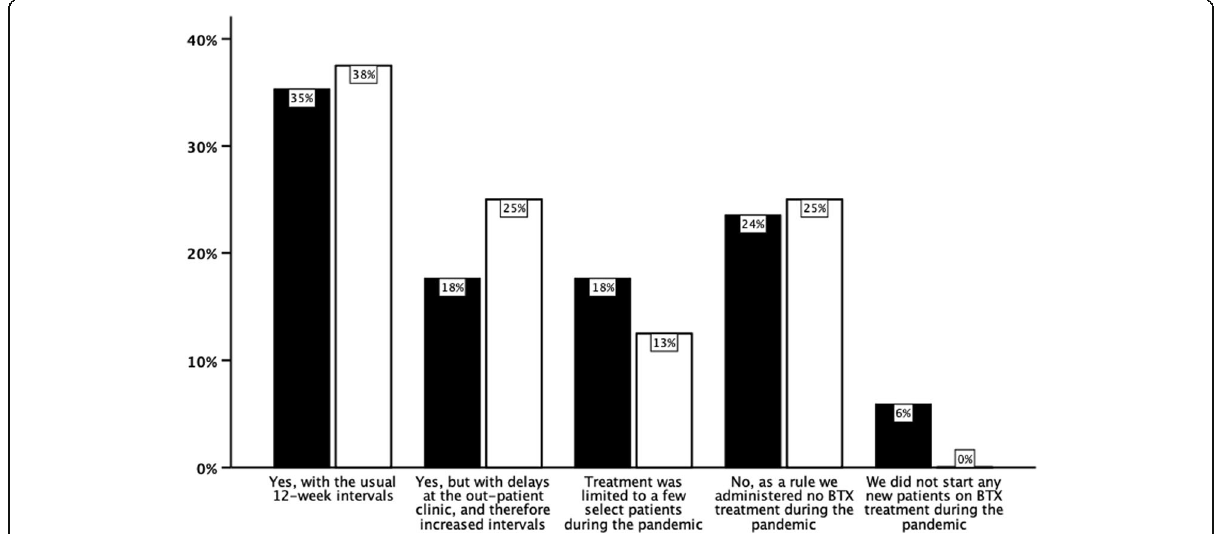
Fig. 1 Botulinum toxin A (BTX) treatment in Denmark (white) and Norway (black) during the lockdown. Respondents replied to the question “ Did